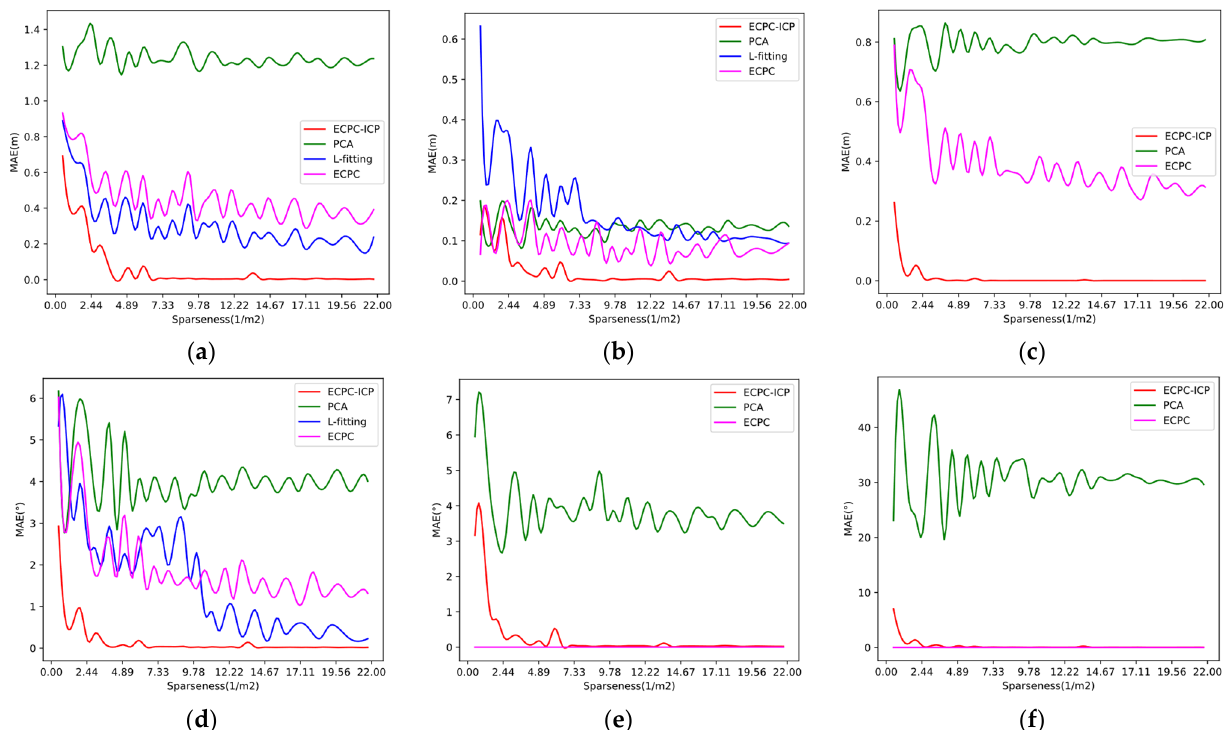
Figure 9. MAE of different algorithms under point clouds with different sparseness. ( a ) MAE of different algorithms on local X -axis; ( b ) MAE of different algorithms on local Y -axis; ( c ) MAE of different algorithms on local Z -axis; ( d ) MAE of different algorithms on local yaw angle; ( e ) MAE of different algorithms on local pitch angle; ( f ) MAE of different algorithms on local roll